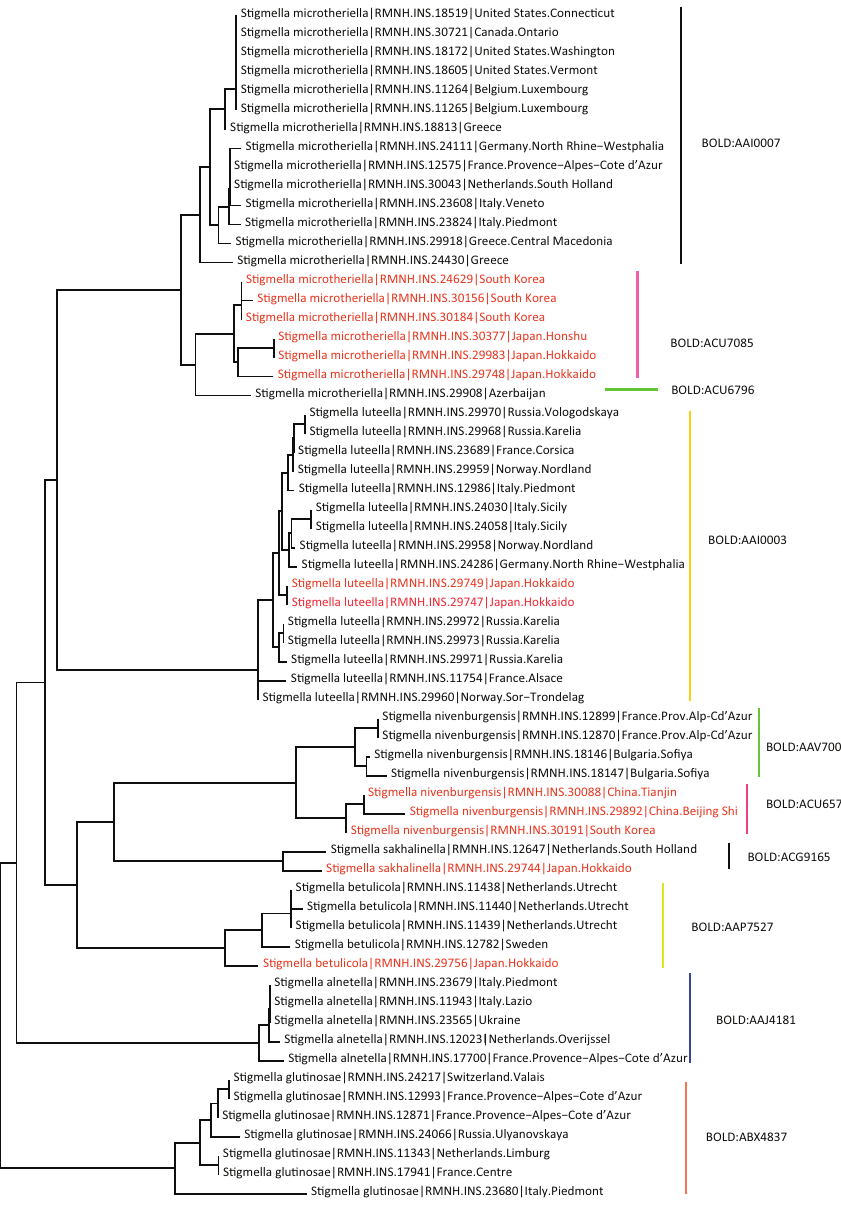
Figure 57. Neighbor Joining tree of DNA Barcodes of Palearctic members of the Stigmella betulicola group. East Palearctic records are presented in red, West Palearctic and imported North American records in black. Barcode Identification numbers are given at the